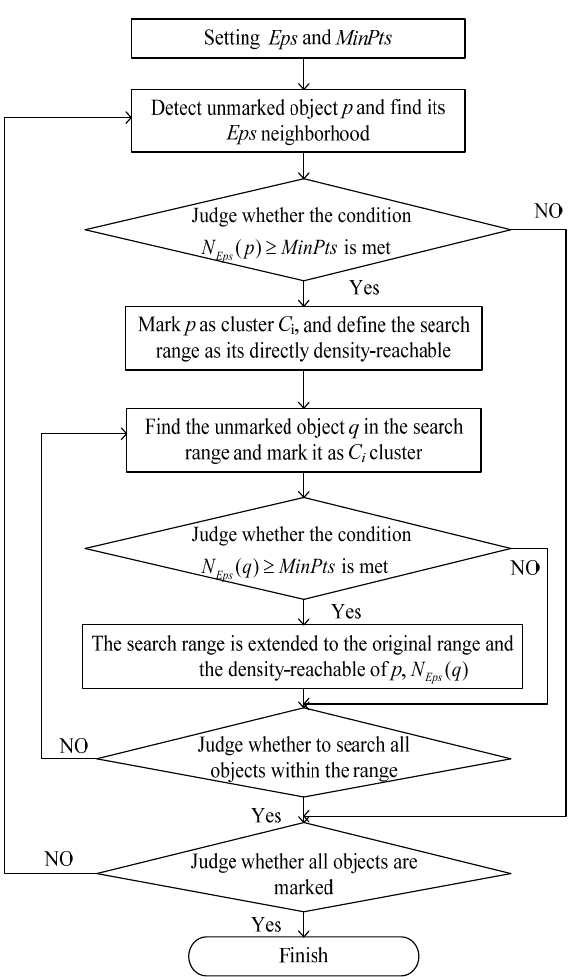
Figure 3. CCDBSCAN algorithm flow chart